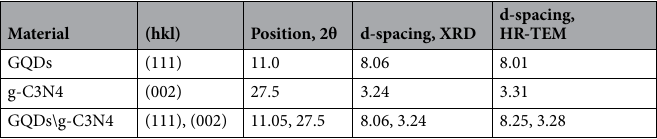
Table 3. The d-spacing estimated from XRD and SAED.